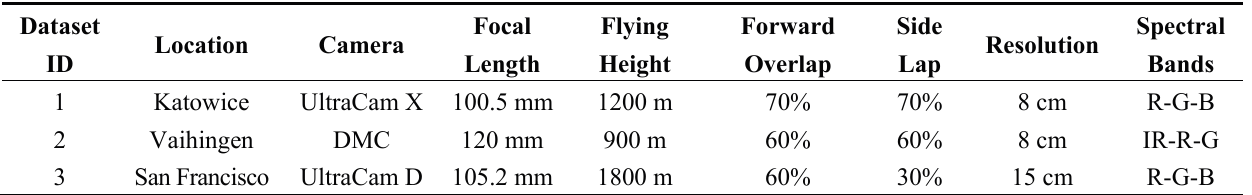
Table 1. Overview of test